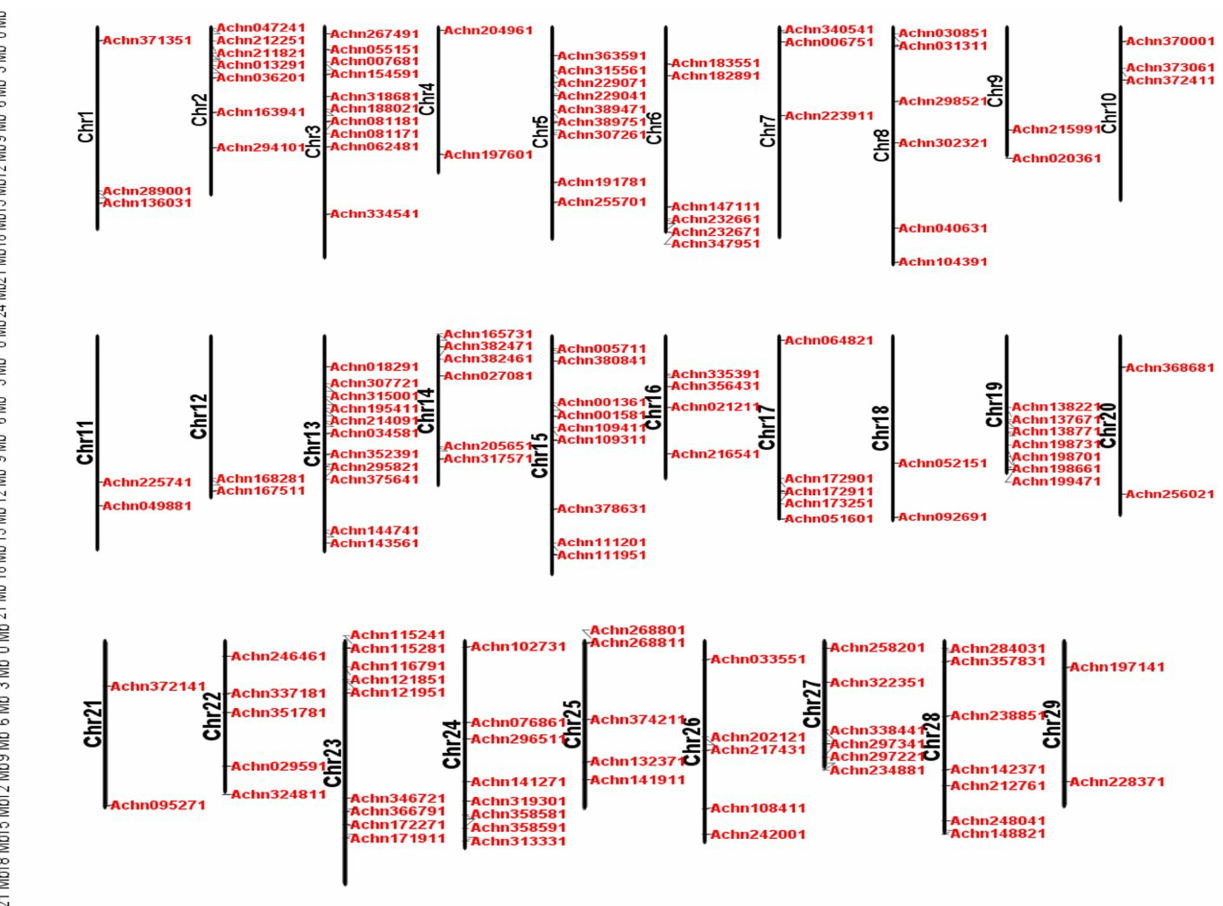
Figure 1. Chromosome distribution of AcMYB TFs in kiwifruit.